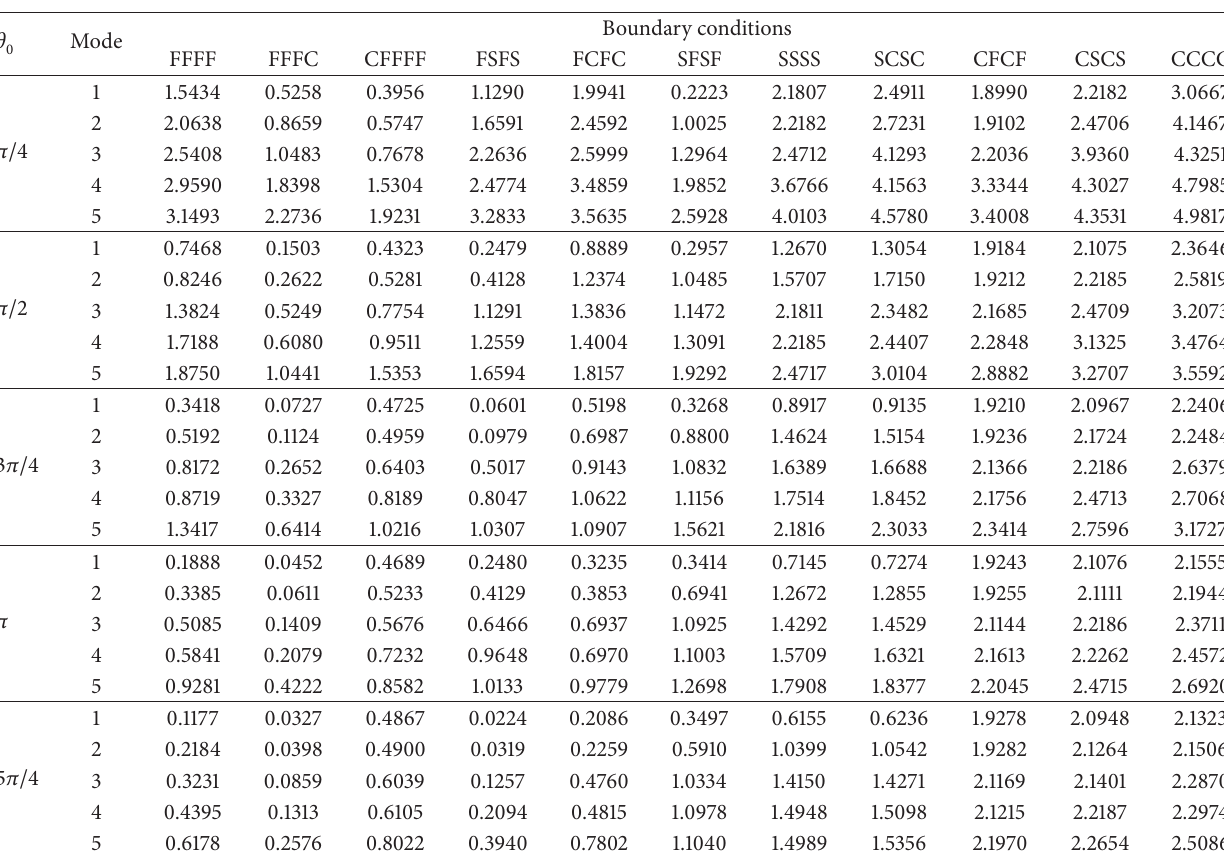
Table 13: The first five frequency parameters Ω = 𝜔𝑅√𝜌( 1 − 𝜇 2 )/𝐸 of an open isotropic spherical shell with various boundary